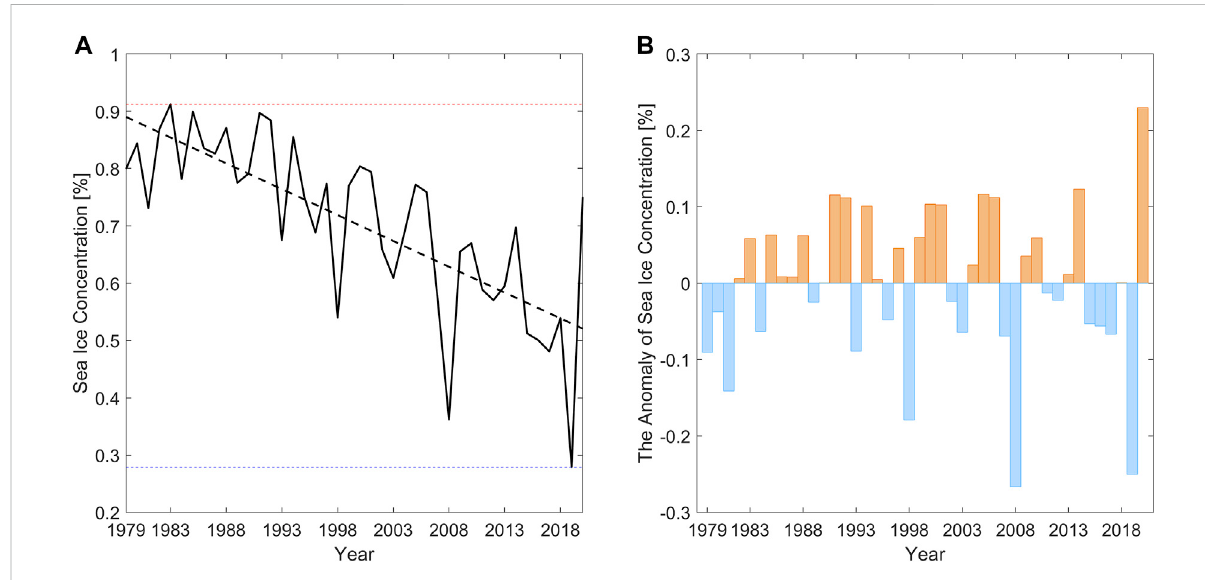
FIGURE 2 ArcticSIC (A) andtheanomalyofSIC (B) forJuly1979 – 2020.Theblackdottedlineisthelineartrend.Thereddottedlineindicatesthemaximum SIC over the past 40 years, while the blue dotted line indicates the minimum SIC during the same time